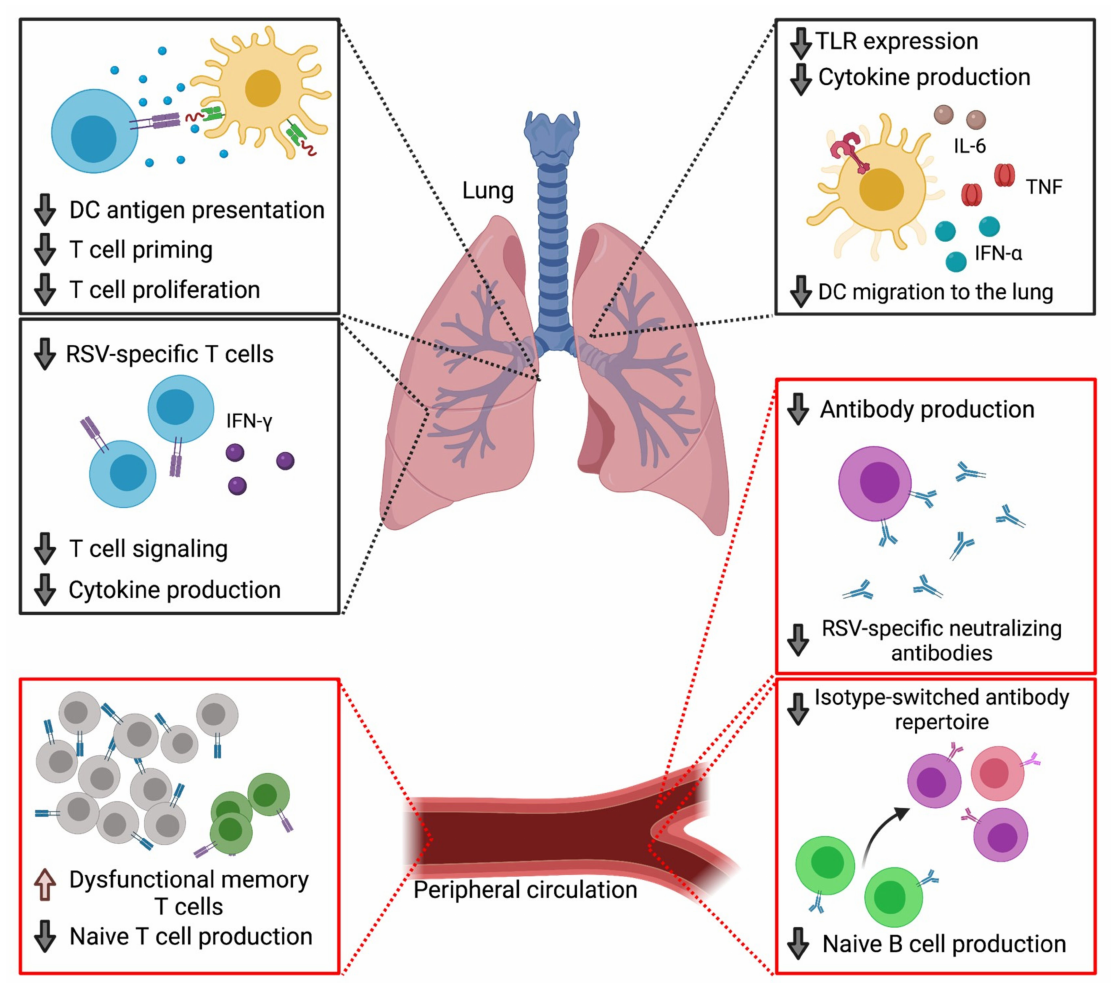
Figure 1. Key features of immune senescence. With age, the production of new T cells entering the periphery declines while pre-existing memory T cells progress into dysfunction. Aged T cells are also impaired in their signaling capacity and are less responsive to in vitro stimulation. Following RSV infection, aged individuals exhibit a reduced frequency of RSV-specific T cells and impaired functional capacity as demonstrated by reduced IFN- γ production. Aged dendritic cells produce lower quantities of many proinflammatory cytokines including IL-6, TNF, and IFN- α in response to various TLR stimulation. They also demonstrate a reduced capacity to prime naïve CD4 and CD8 T cells as measured by proliferation and cytotoxicity. Aging also results in delayed migration of DCs into the lung and lung-draining lymph nodes following viral infection. The aged humoral immune response is characterized by a decrease in the production of naïve B cells, as well as a reduction in class-switch recombination and somatic hypermutation, resulting in a reduced diversity of the B cell repertoire. RSV-specific antibody responses including serum neutralizing antibody titers decline with age. Created with BioRender.com. Accessed on 3 June